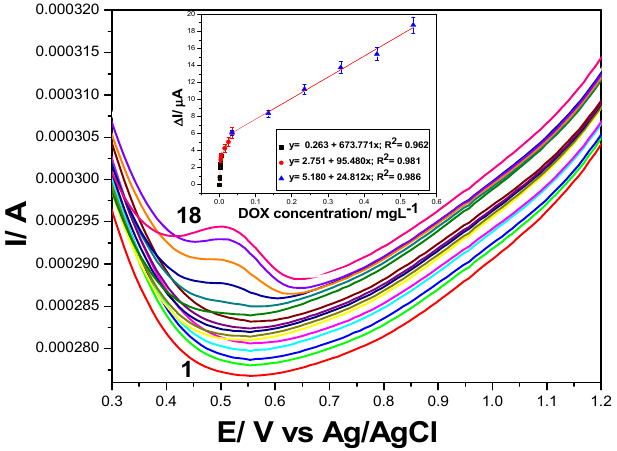
Figure 10. Square wave voltammograms recorded on GRQD/CNT paste electrode in 0.1 M Na 2 SO 4 supporting electrolyte (curve 1) and in the presence of various DOX concentrations: curves 2–6: 0.0002–0.001 mgL − 1 DOX; curves 6–10: 0.001–0.005 mgL − 1 ; curves 10–13: 0.015–0.035 mgL − 1 ; curves 13–18; step potential (SP) 10 mV, modulation amplitude (MA) 200 mV; Hz, and a scan rate of 100 mVs − 1 , potential range: 0.000 to +1.50 V /Ag/AgCl. Inset: Calibration plots of the currents recorded at E= +0.510 V vs. Ag/ AgCl with DOX concentrations.